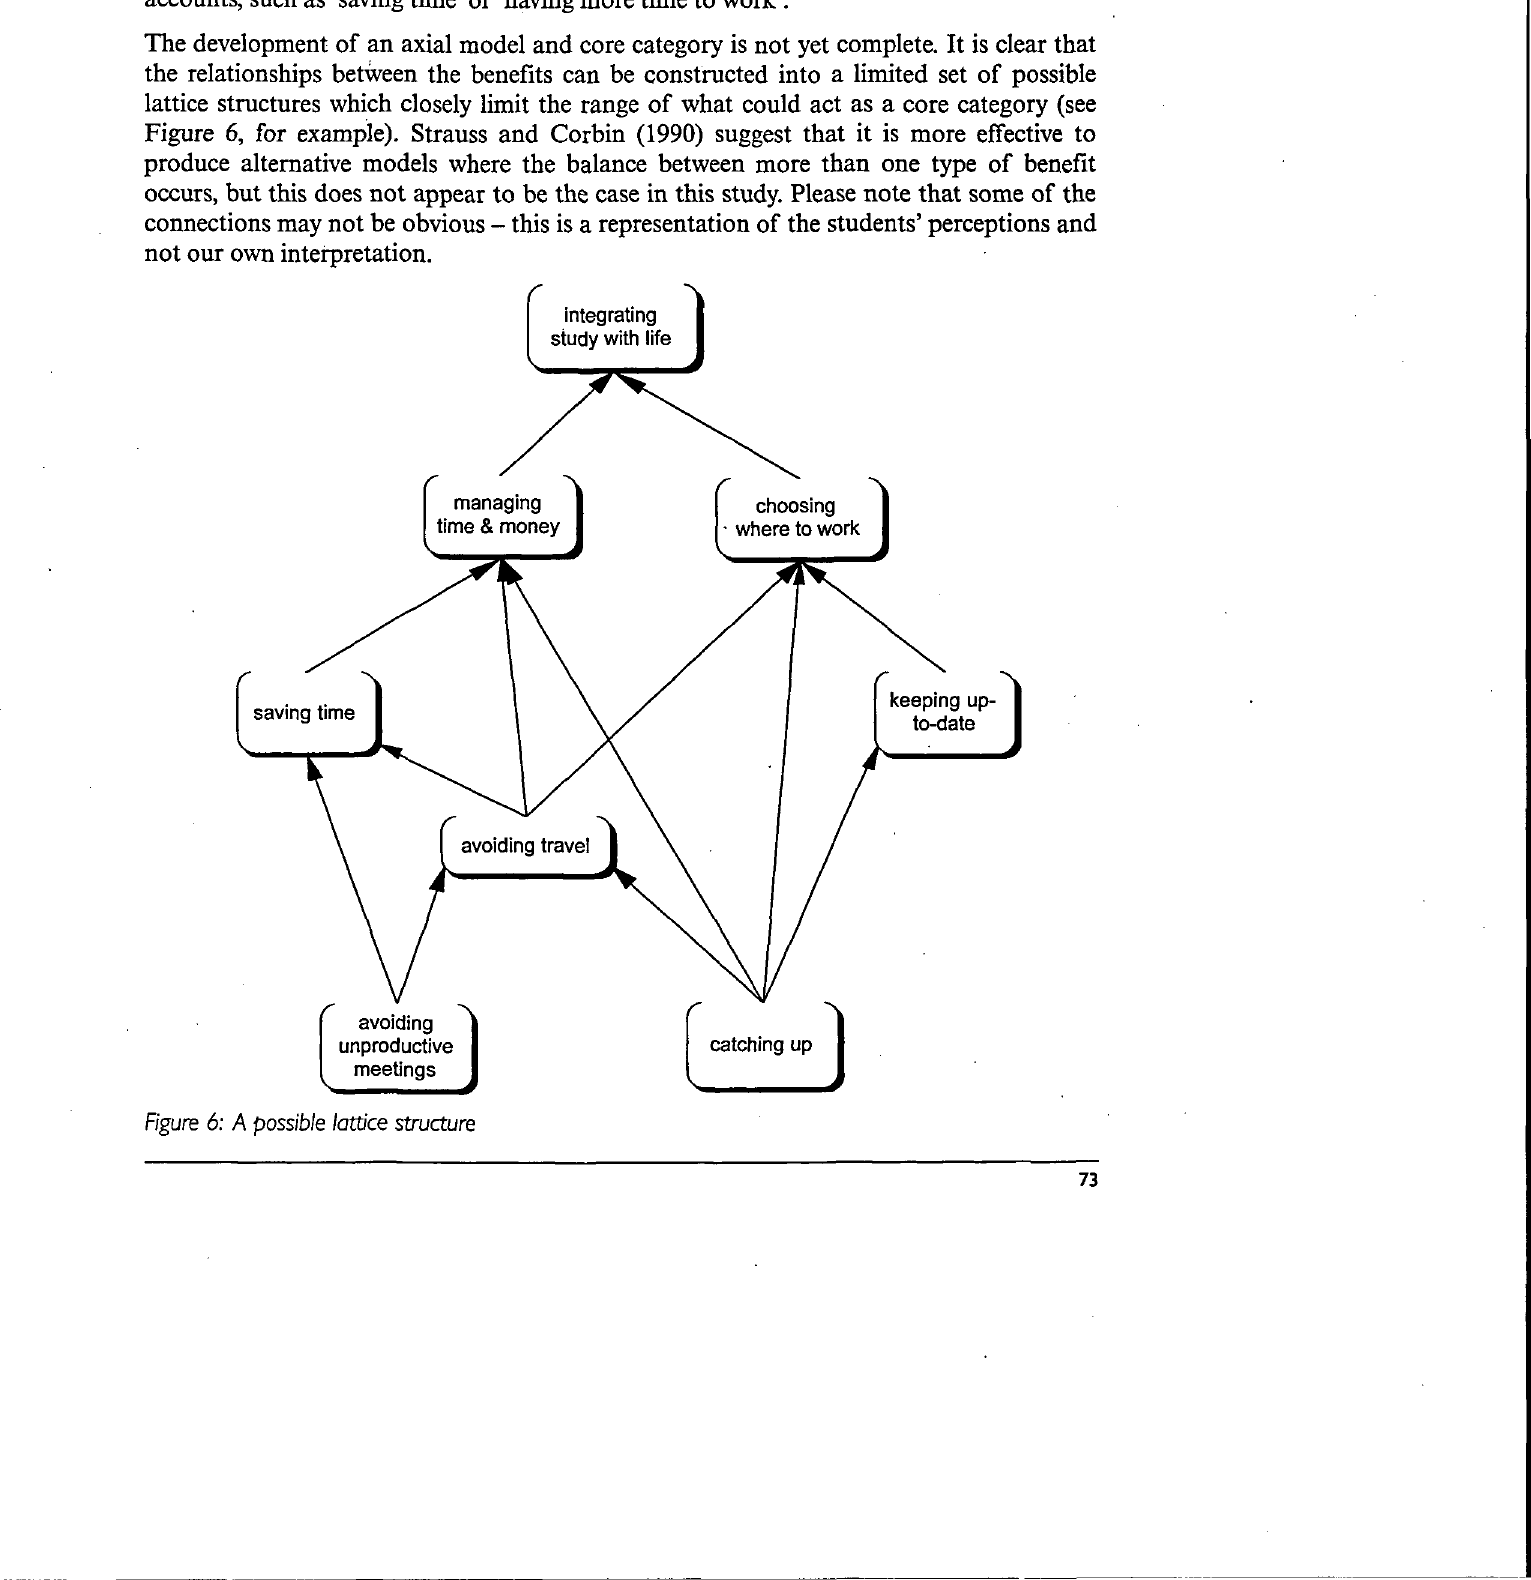
Figure 6: A possible lattice